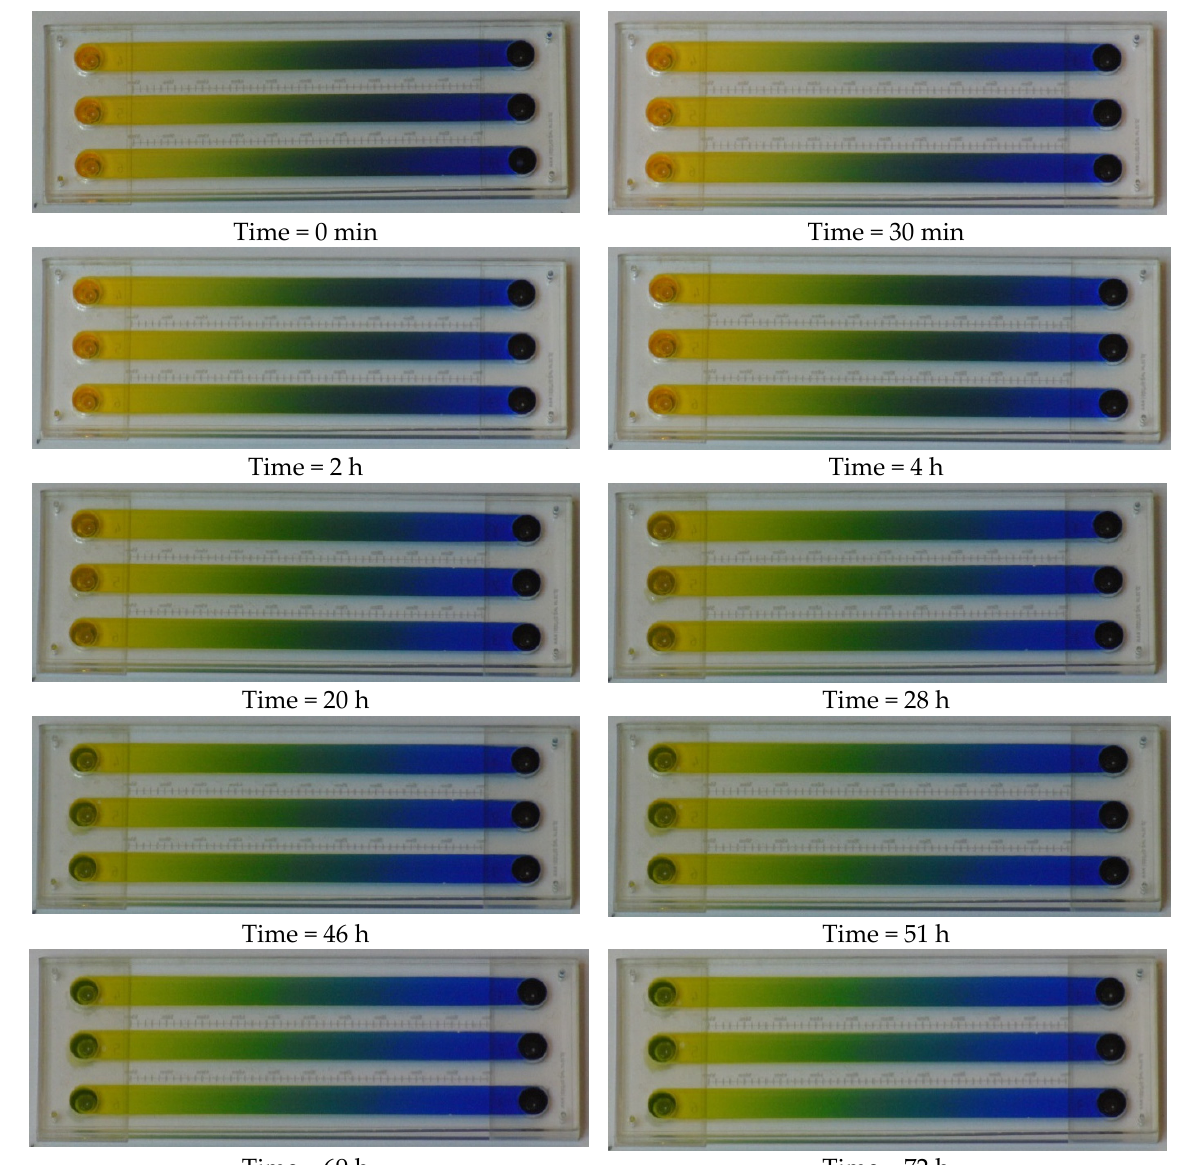
Figure A1. Visualization of stability of color indicators (fluorescein and methylene blue) counter-current concentration profiles over time.